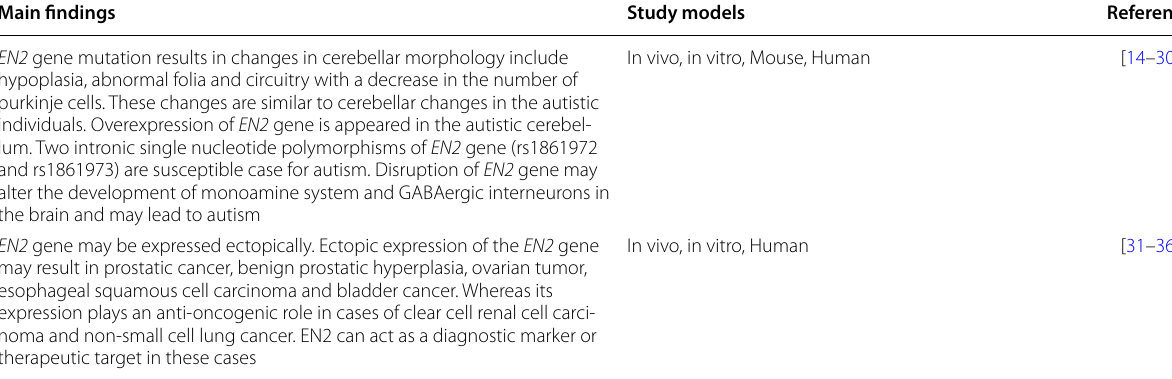
Table 2 Effects of mutation and ectopic expression of EN2